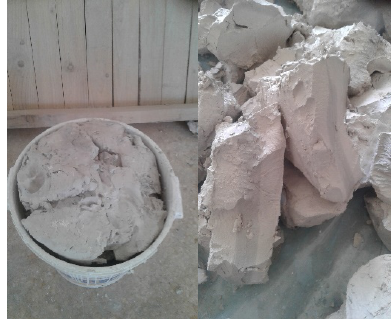
Figure 1. Marble sludge waste in wet state.